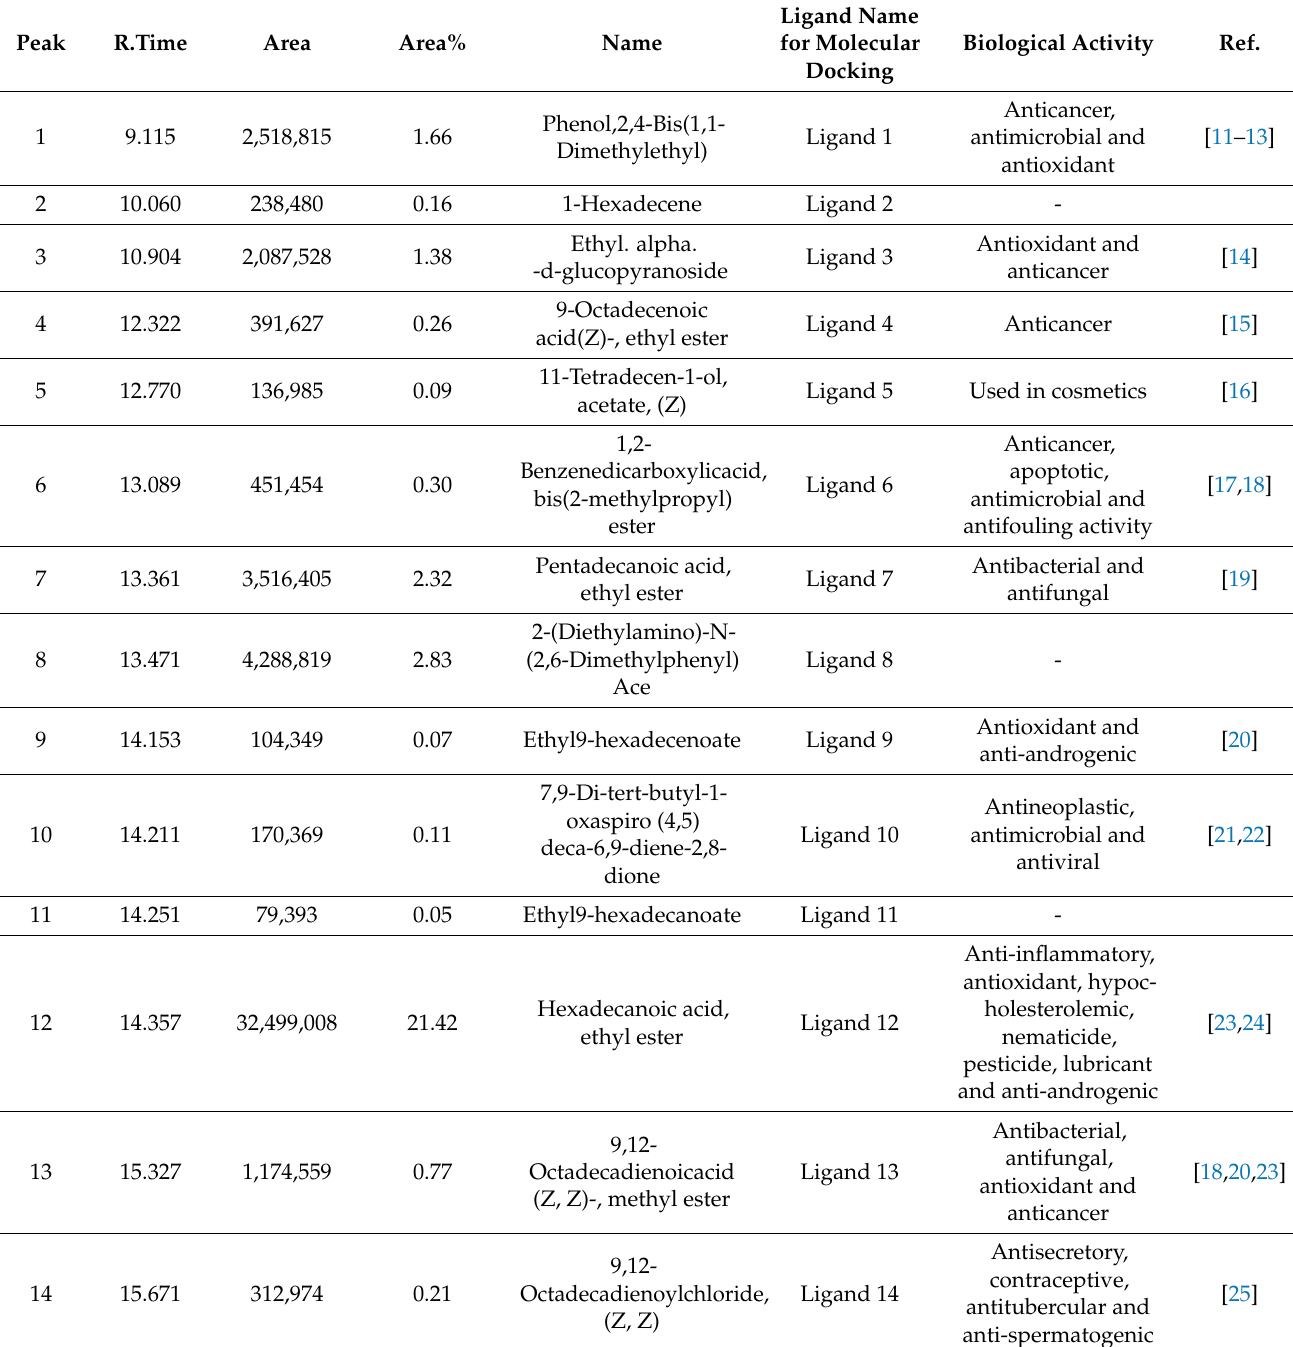
Table 2. Gas chromatography–mass spectrometry (GC-MS) data of the bioactive compounds identi- fied in this study. These bioactive compounds were identified from the ethanolic extract of Pleurotus ostreatus